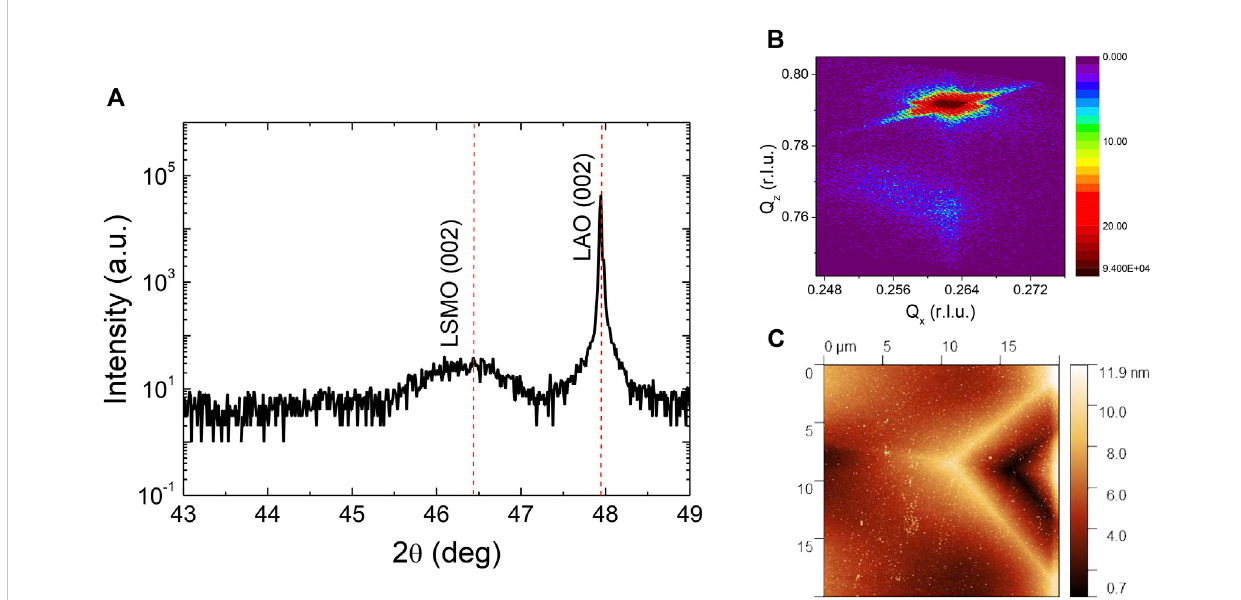
FIGURE 1 (A) XRD pattern of LSMO/LAO thin fi lm showing a smooth and epitaxial growth of ~ 24 unit cells. This thickness is in close correspondence to that determined by in situ RHEED (Supplementary Figure S1A) and by XRR (Supplementary Figure S1B). The corresponding angles for LSMO (002) and LAO (002) are indicated by the red dotted lines. (B) Reciprocal space map of the (103) Bragg re fl ection peak of LAO and LSMO shows that the grown fi lm is elongated out of the plane direction to match the lattice parameter of the LAO substrate. (C) AFM image shows structural twin domains of the LAO substrate.